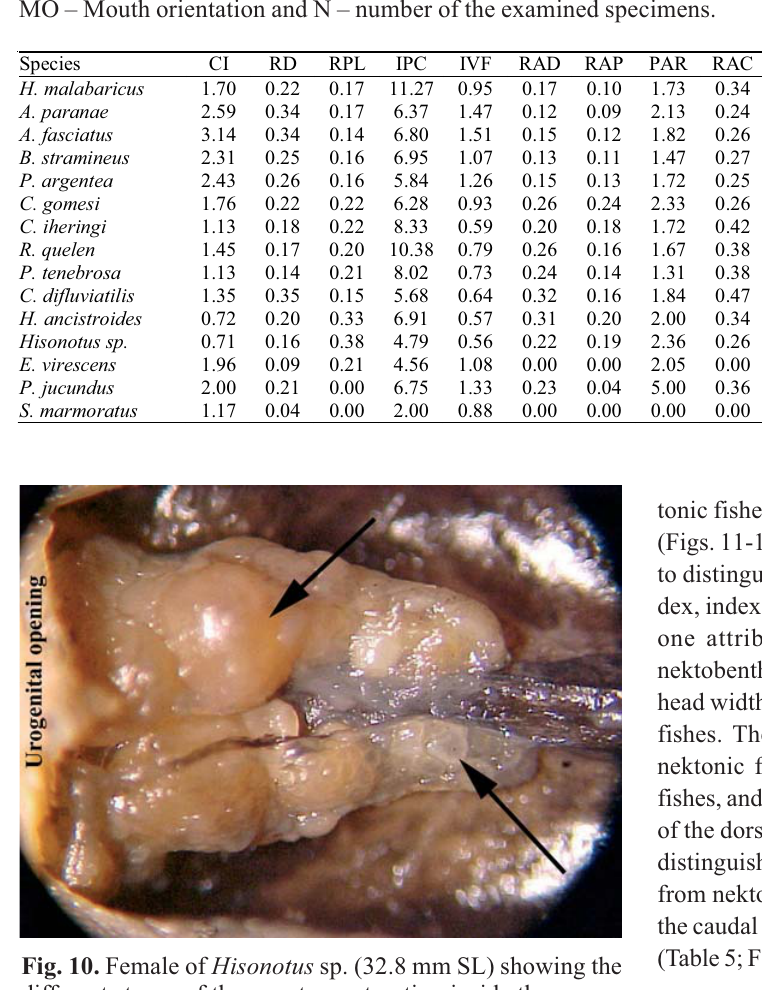
Table 4. Mean values of the 16 ecomorphological attributes calculated for the 15 fish species recorded at the Paulicéia stream.